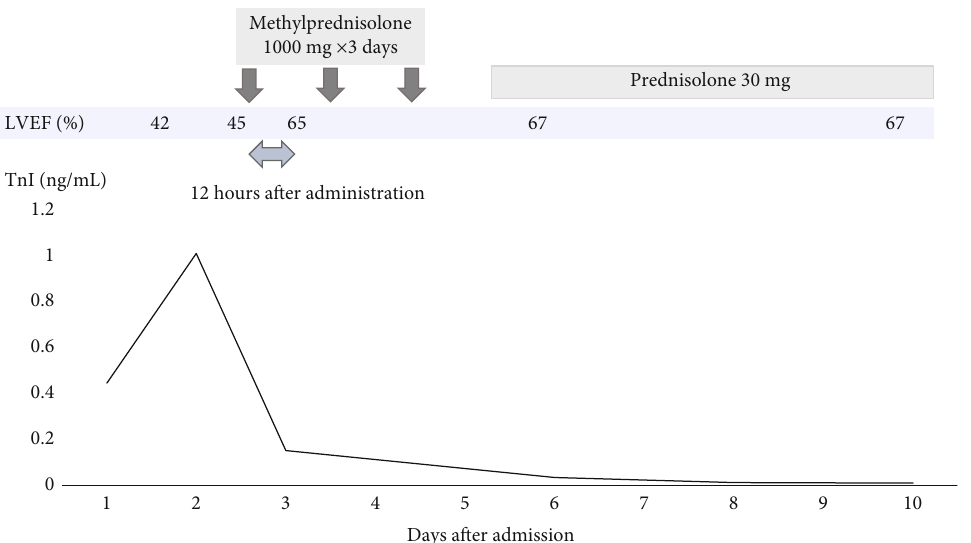
Figure 3: Changes in troponin I (TnI) level and left ventricular ejection fraction (LVEF) before and after steroid therapy. Rapid improvements in TnI and LVEF were found after the steroid